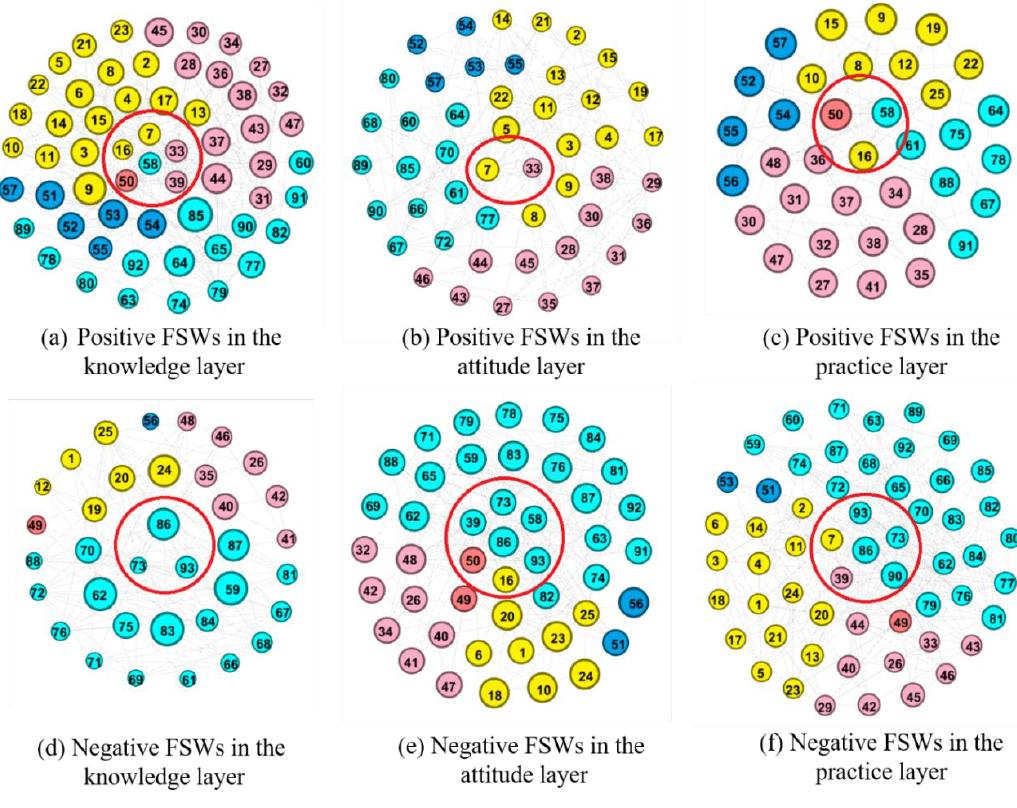
Figure 3. Positive and negative FSW social sub-networks. Table 3. Proportion of positive FSWs in di ff erent